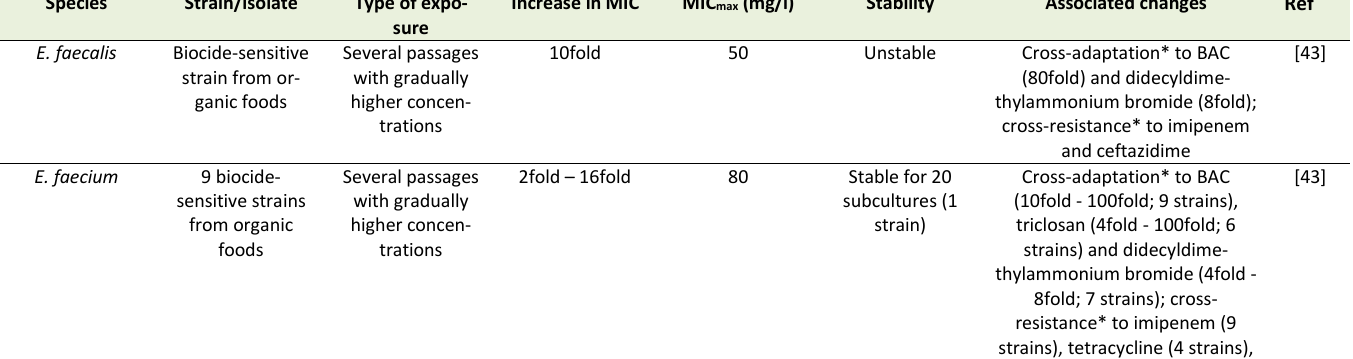
TABLE 2 (continued): Adaptive response of Gram-positive bacterial species to sublethal CHG exposure, adapted from